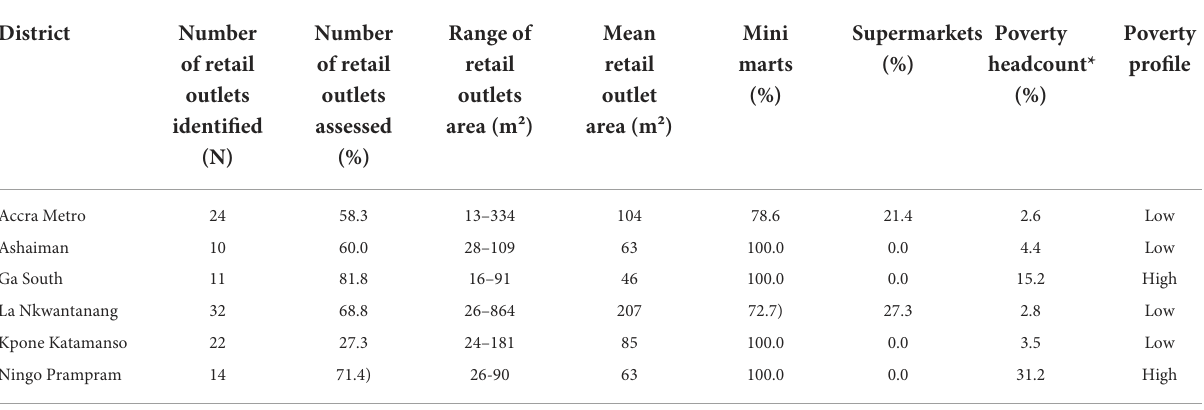
TABLE 1 Attributes of identified retail outlets located within the study